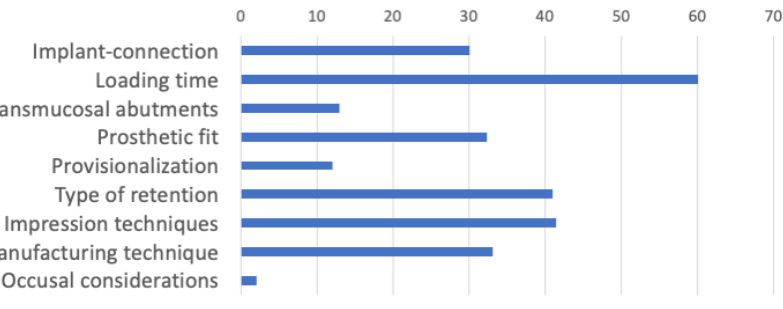
Figure 3. Comparison of the Summary Scientific Scores (SSS) among distinct prognosis factors.